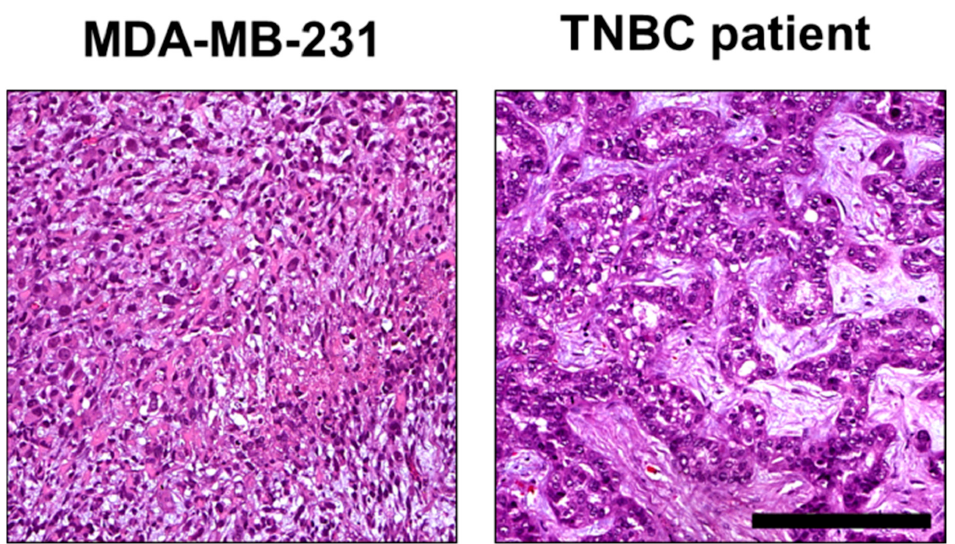
Figure 8. Comparison of histomorphology in MDA-MD-231 CAM ovografts and TNBC patient tumor tissue. Higher magnification of the MDA-MB-231 ovograft (Figure 7A) and human TNBC case (Figure 7I). These images display tumor growth patterns similar to those observed in tumor areas of both MDA-MB-231 CAM ovografts and TNBC patient tumor tissue. In both cases, the TNBC tumor cells showed high pleomorphism and partial cord-like growth surrounded by fibromyxoid tumor stroma (hematoxylin and eosin; each at 200× magnification). Scale bar: 200 µm ( applies to both cell lines ) .